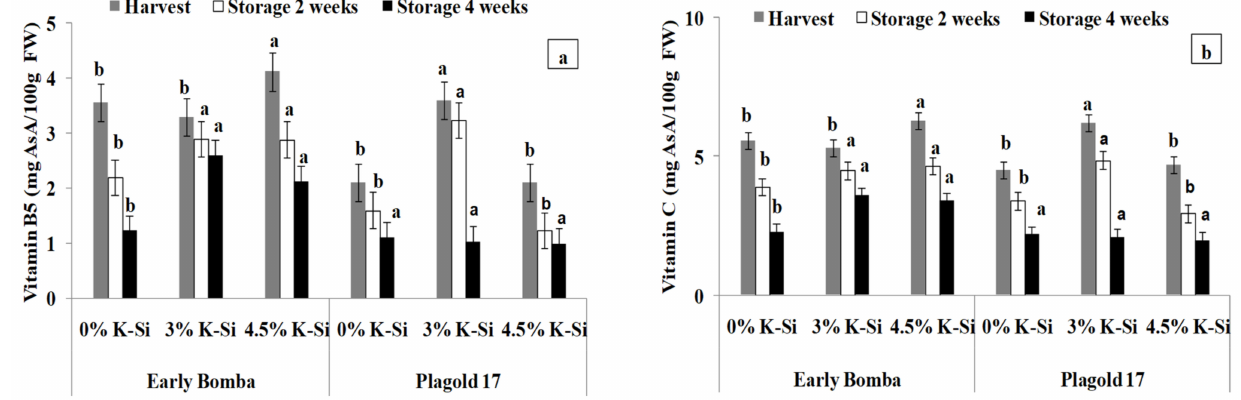
Figure 3. Influence of potassium silicon spray and storage period on vitamin B5 ( a ) and vitamin C ( b ) contents among two peach cultivars at harvest and after 2- and 4-week cold storage periods during the growing seasons 2021–2022. Abbreviations: Values are the means ( n = 3) ± standard error. Different letters a, b, indicate differences ( p < 0.05) among K-Si treatments in each cultivar according to Scheffe’s multiple range